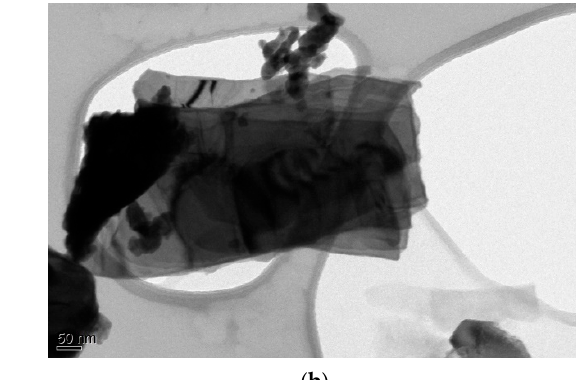
2 Ti 3 flakes and ( c ) PVDF/BT (7%) membrane.